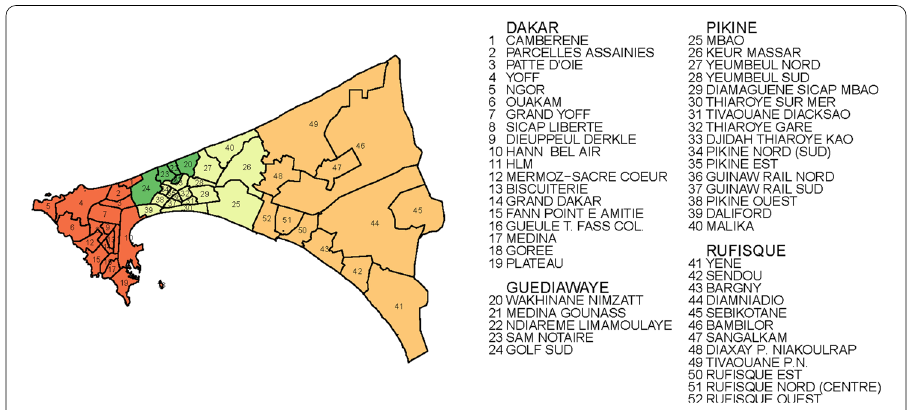
Fig. 1 Map of the Dakar region, its four departments and 52 borough